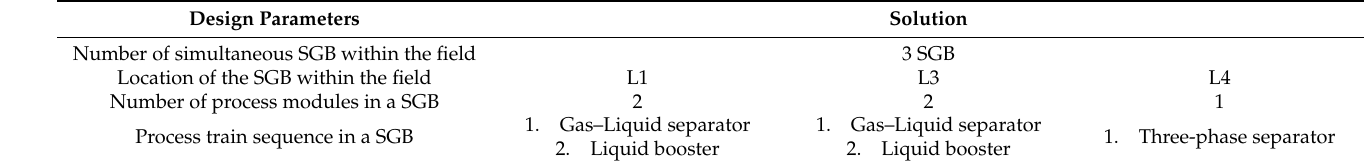
Table 6. Solution to the problem specification.